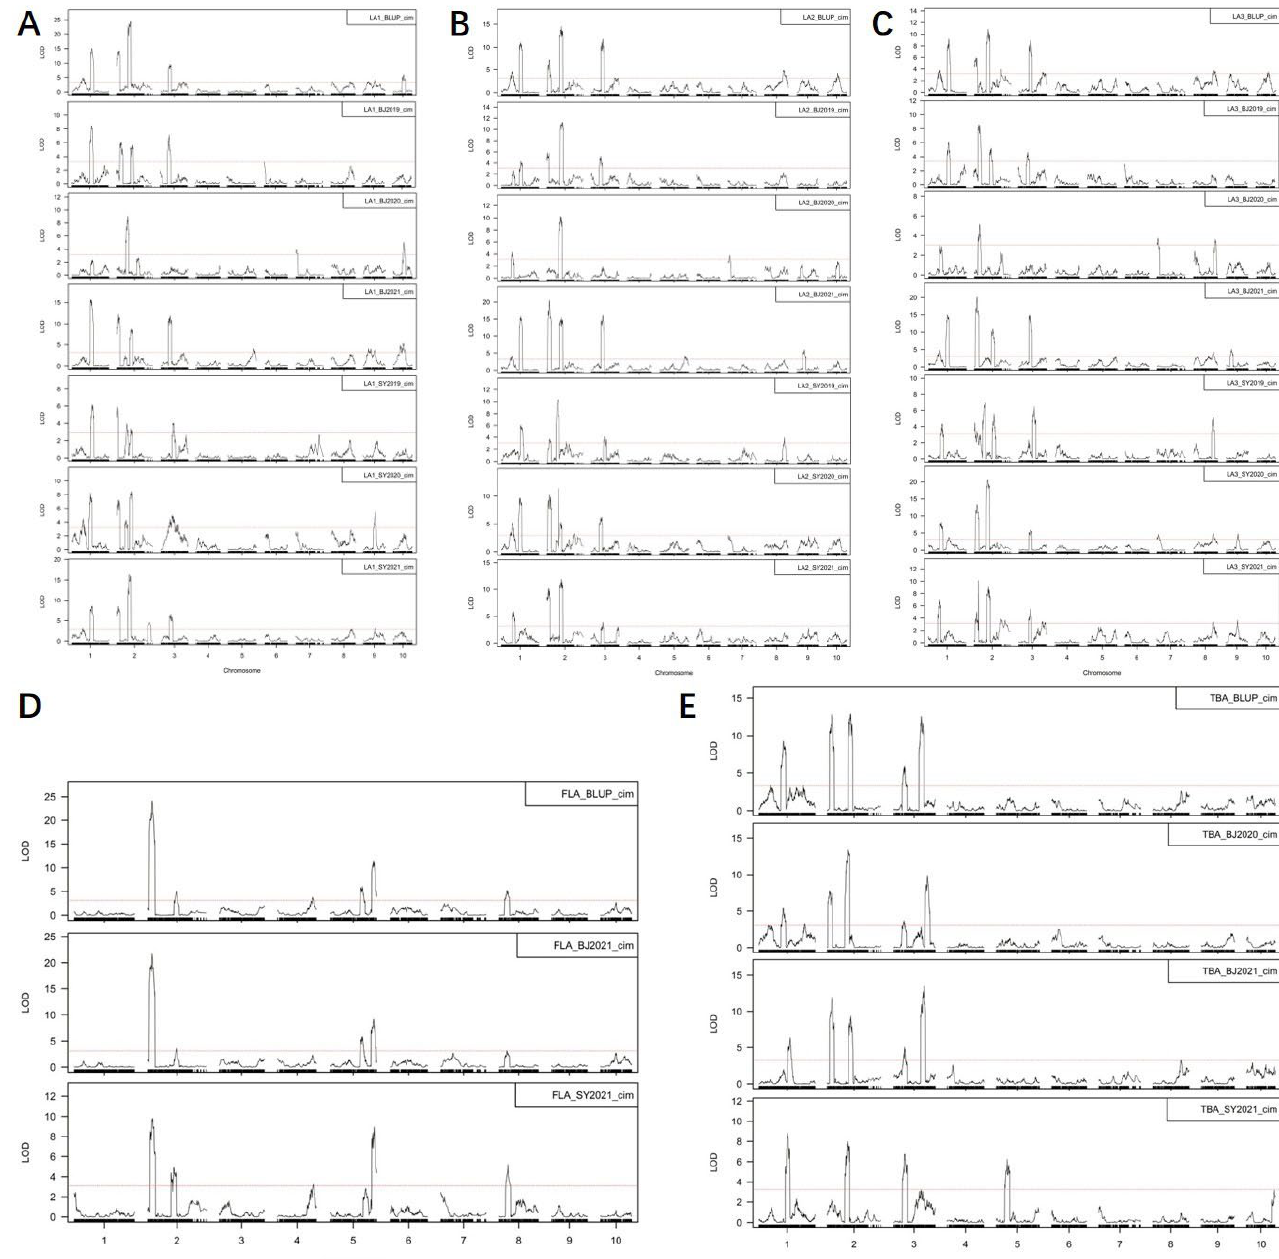
Figure 5. Comparisons between QTLs for lateral angles of BLUPs and individual environments. ( A – E ) The results of QTL mapping for LA1 ( A ), LA2 ( B ), LA3 ( C ), FLA ( D ) and TBA ( E ) of BLUP and individual environments, separately. The y -axis represents -log10 transformed p-values from t -testing; the red dotted line represents the cutoff. LA1_BLUP_cim, LA2_BLUP_cim, LA3_BLUP_cim, FLA_BLUP_cim and TBA_BLUP_cim represents the QTL mapping that was conducted with the BLUP values calculated for LA1, LA2, LA3, FLA, and TBA across different environments separately and the compo- site interval mapping was used mapping each trait. BJ2019, BJ2020, BJ2021, SY2019, SY2020 and SY2021 represents the environment of the Haidian district in Beijing in 2019 and 2020, and Shunyi district in Beijing in 2021 and the Shenbei district in Shenyang in 2019, 2020 and 2021.